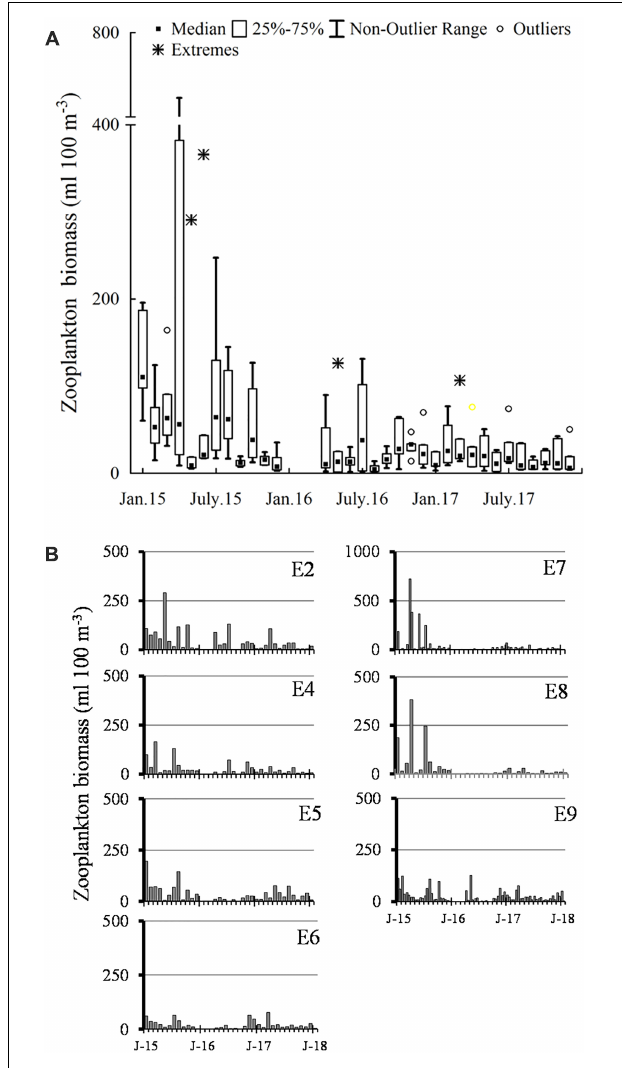
FIGURE 12 | Percentage of dead zooplankton recorded from 2015 to 2017. WD, without data. (A) E2; (B)